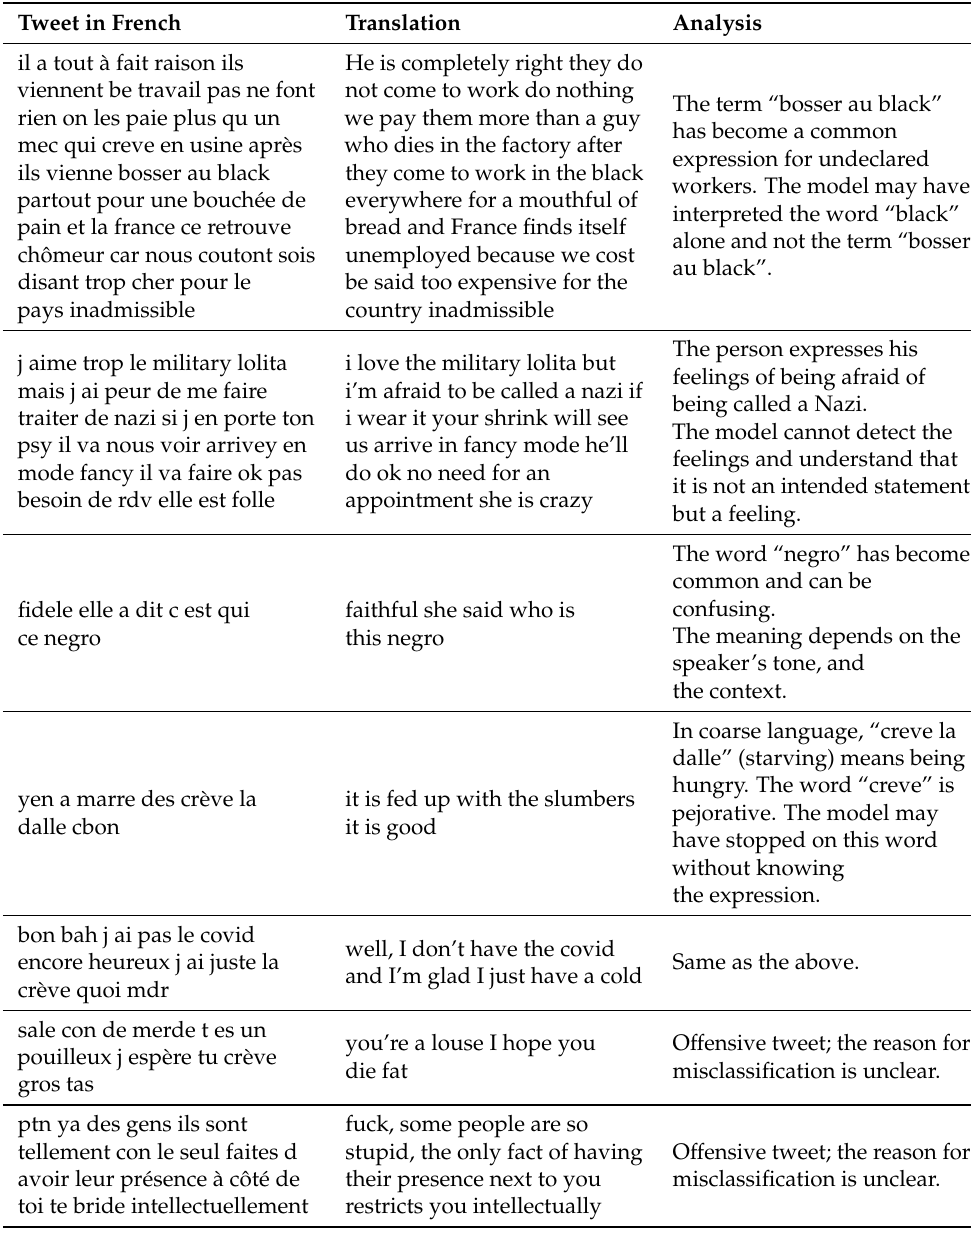
Table 12. Error analysis—false